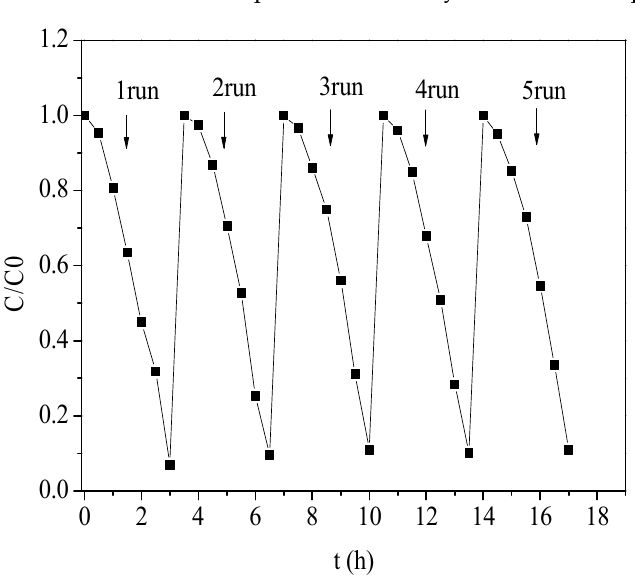
Figure 7. Cyclic stability test curve of ZnTiO 3 /Bi 2 WO 6.